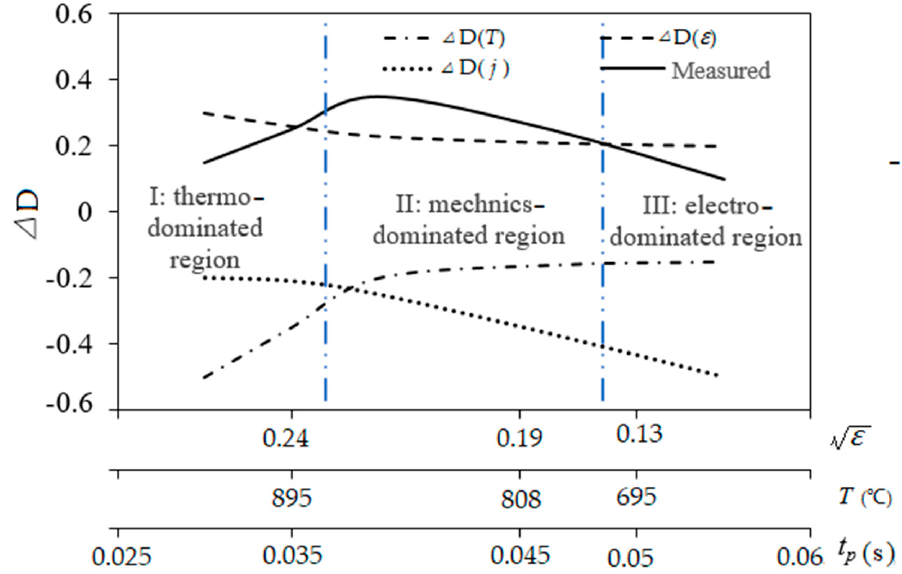
Figure 13. Schematic competition among plasticity components under EPT.